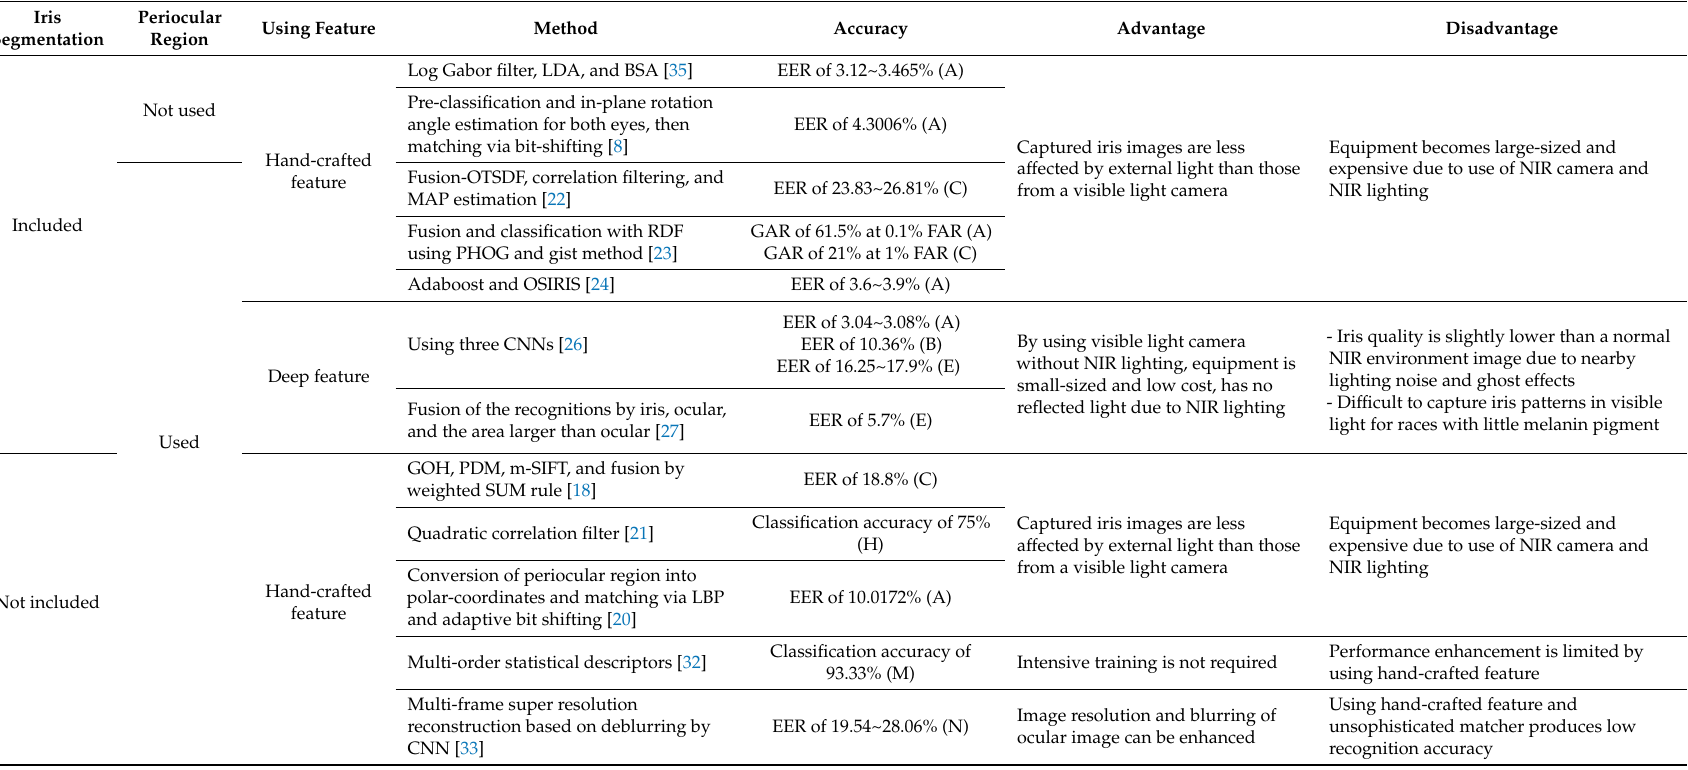
Table 1. Comparisons of proposed and previous researches (d (cid:48) , EER, GAR, and FAR mean d-prime value, equal error rate, genuine acceptance rate, and false acceptance rate, respectively. Their concepts are explained in Sections 4.4 and